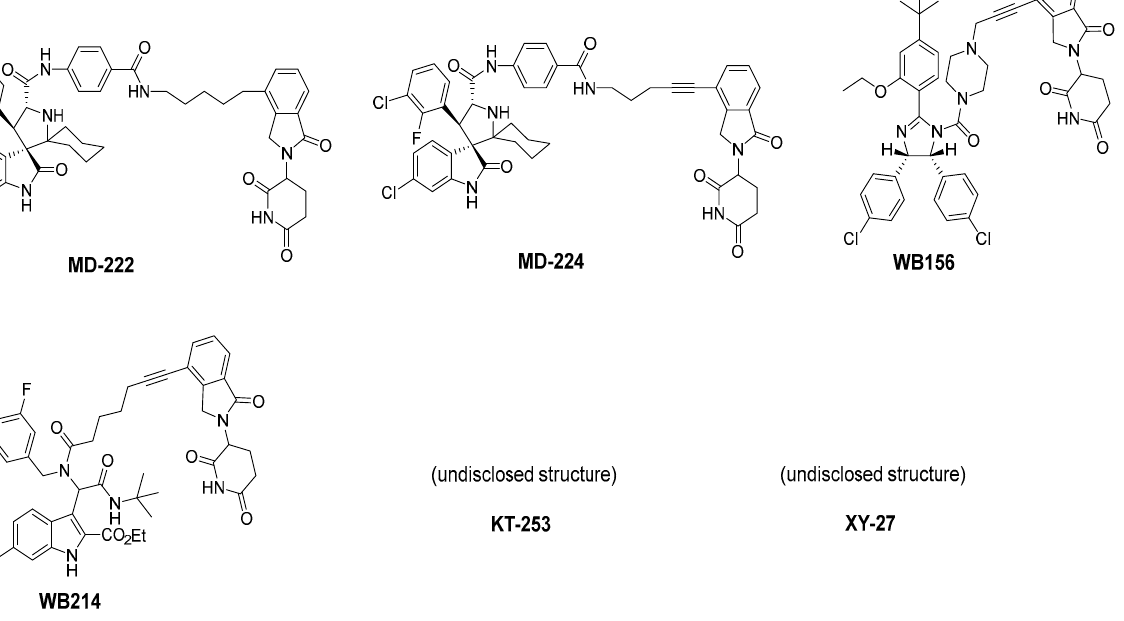
Figure 7. Chemical structure of PROTAC–MDM2